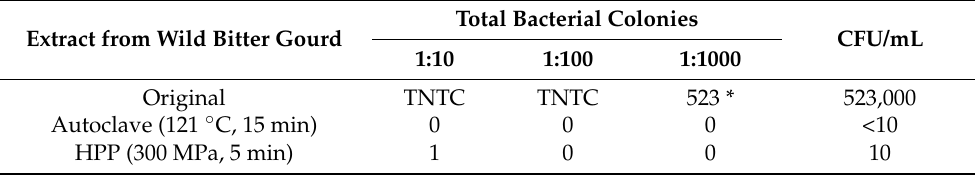
Table 3. Total bacterial counts of wild bitter gourd extract treated using different treatments. Extract from Wild Bitter Gourd